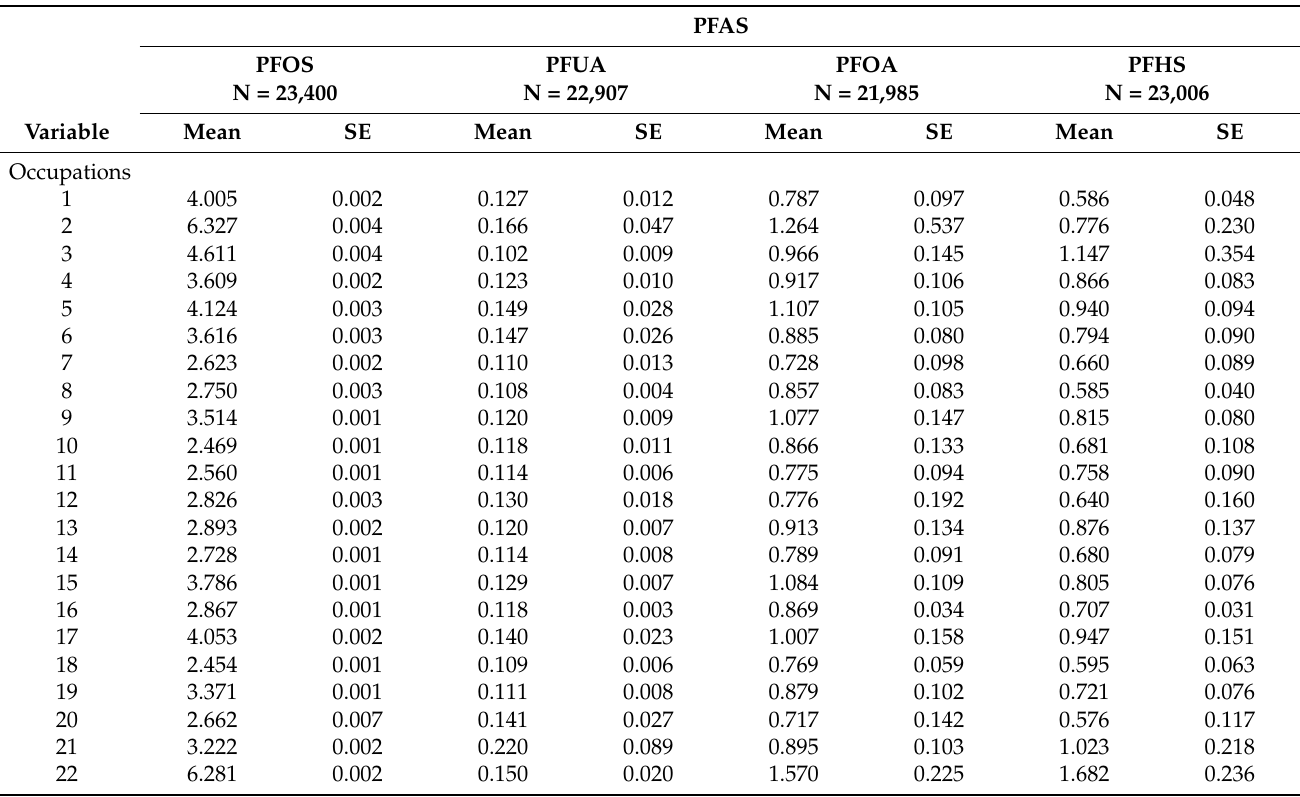
Table 2. Summary mean differences in participants’ serum PFAS (PFOS, PFUA, PFOA,